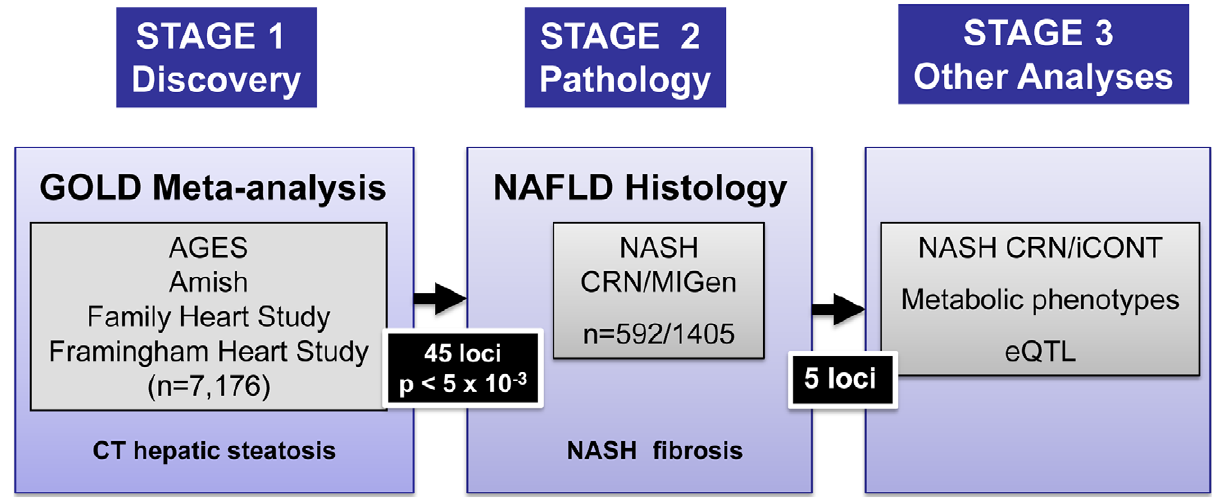
Figure 1. Study design. Meta-analysis of genome-wide association data was performed in Stage 1 across the cohorts shown. SNPs representing the best associating loci were genotyped in histology based NAFLD samples (Stage 2) from the NASH CRN matched to genome wide genotyped and imputed MIGen controls. The effects of the five NAFLD associated SNPs on NASH CRN/iCONT, metabolic phenotypes and eQTLs in liver and adipose tissue were then performed (Stage 3).